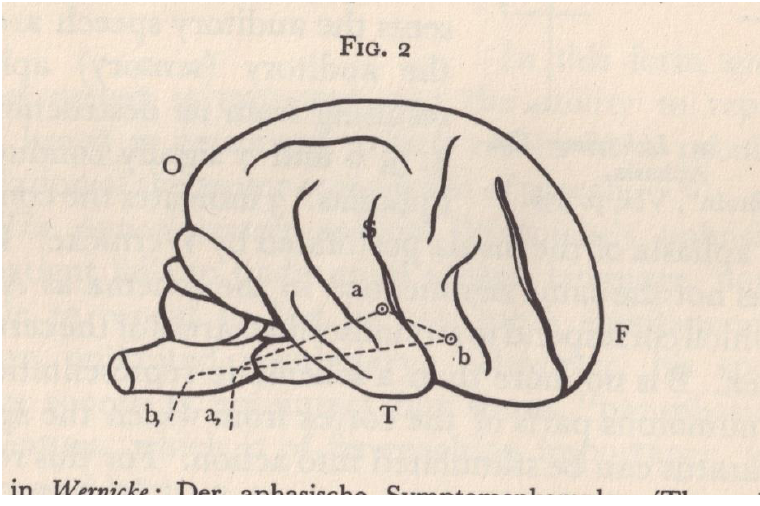
Figure 5. Kerry Tribe, still from The Aphasia Poetry Club (2015), three-channel video with sound, 28:27 min.